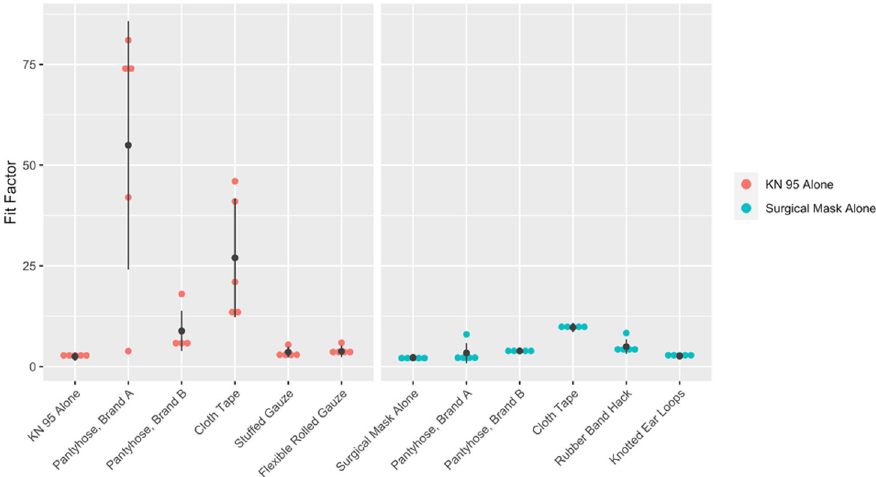
Fig 4. A single fit hack applied five times to one individual demonstrates how reliable the application of a hack is at improving fit